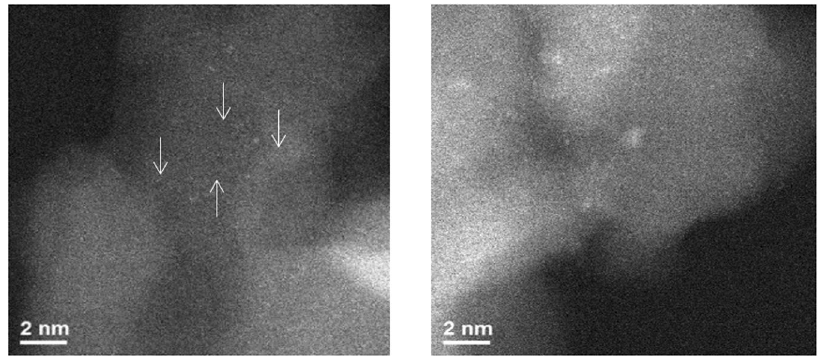
Figure 3. HAADF-STEM images of Pd s - θ -alumina post NO oxidation experiment show ( A ) single atoms and ( B ) small